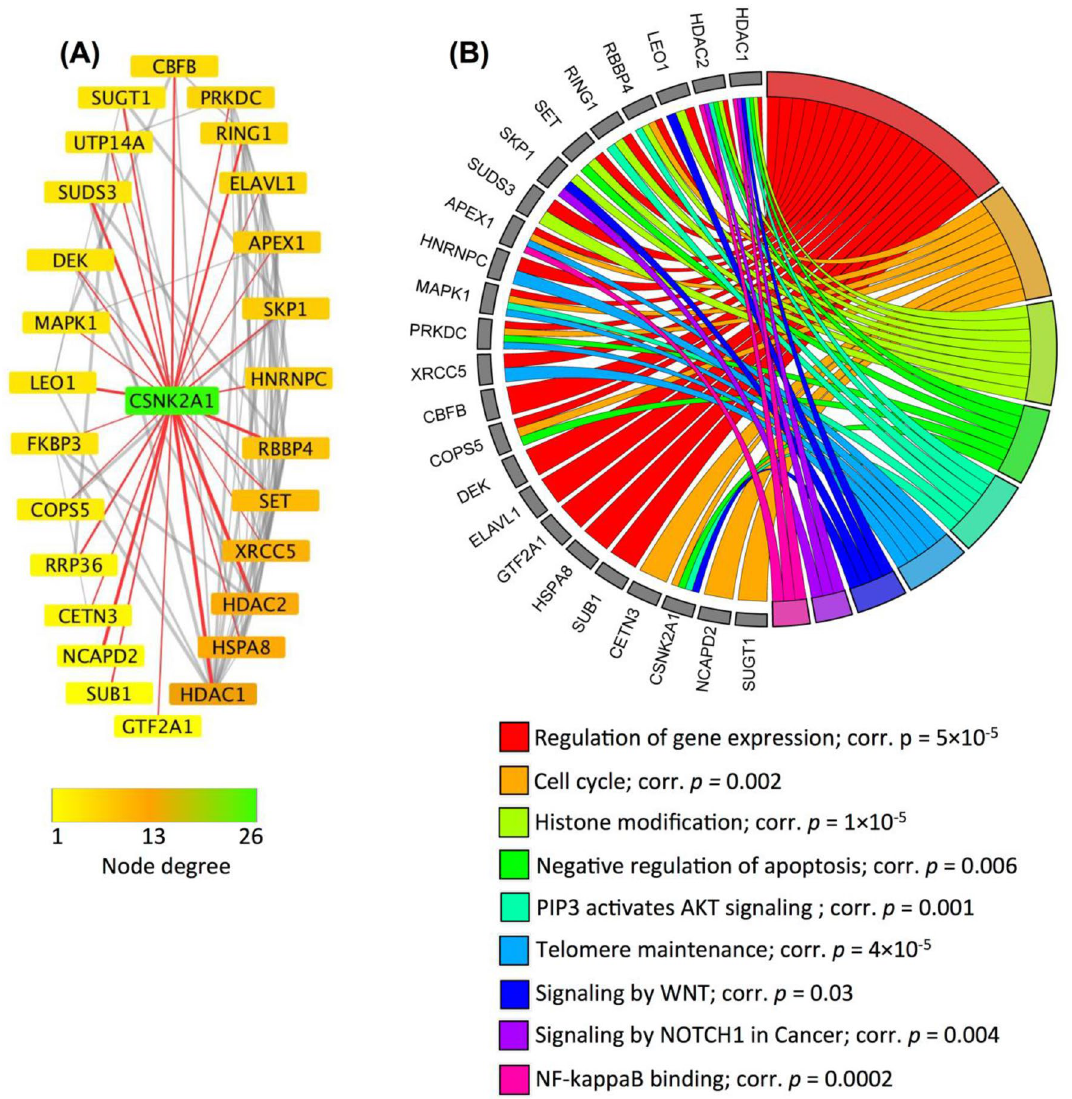
Figure 4. Protein–protein interaction network of CK2α (a protein encoded by CSNK2A1 ). STRING and Cytoscape were used for PPI network analysis of the protein products corresponding to the 649 genes to identify binding partners of CK2α ( CSNK2A1 ). The analysis identified 26 interaction partners of CK2α ( A ). Functional profiling using gProfiler was conducted for the CK2α interaction partners and was visualized in chord plot ( B ). All terms shown in the chord plot were significantly enriched with corrected p value (corr. p ) <